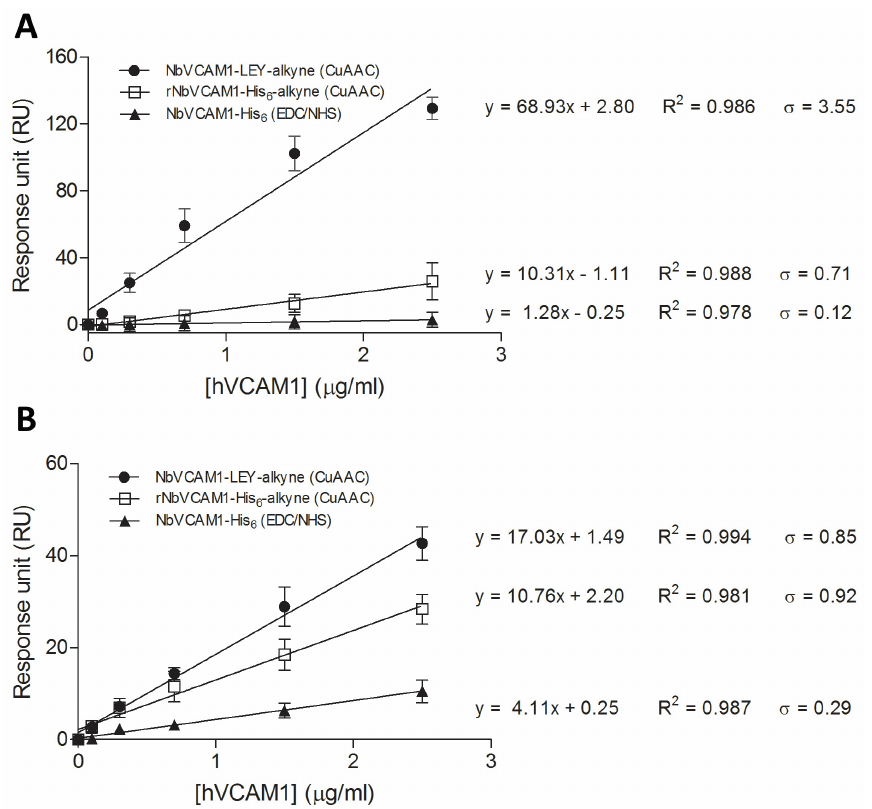
Figure 5. Dose–response curves for the binding of hVCAM1 from: R & D Systems ( A ); and Peprotech ( B ) to VCAM1-targeting nanobodies that are conjugated to different flow cells of the C1 chips via different chemistries. Table 1. The sensitivity (S), detection limit (DL) and quantitation limit (QL), all displayed in μ g/mL, for the binding of recombinant human VCAM1 antigens to the nanobody-conjugated flow cells prepared by the different coupling methods.